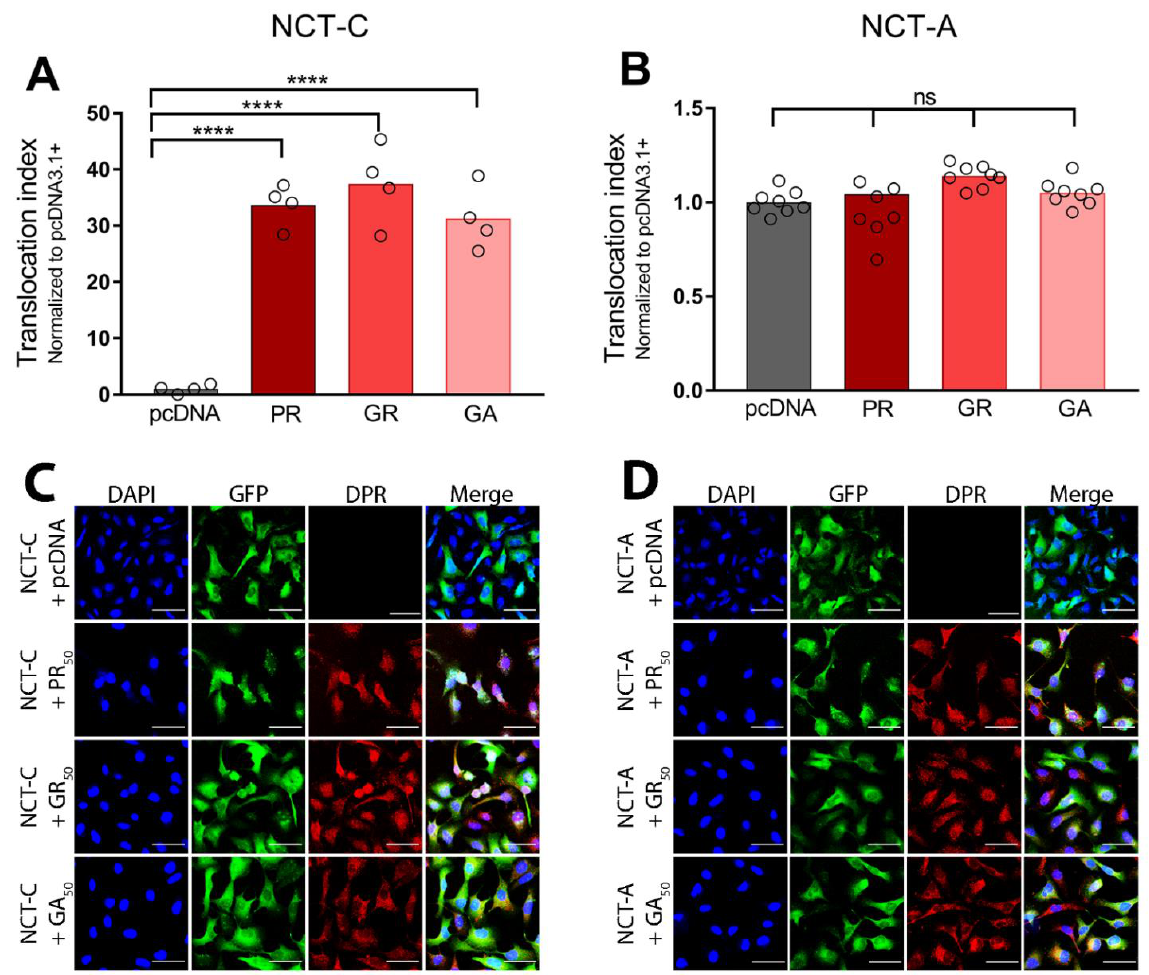
Figure 3. DPRs disrupt the classical nuclear export pathway. ( A ) Bar graph of the translocation index of the NCT-C biosensor after 24 h transfection of an empty vector control (pcDNA3.1+), PR 50 , GR 50 , or GA 50 . Translocation indices were normalized to pcDNA3.1+ (1 = GFP predominantly cytoplasmic). Each condition was performed with 4 technical replicates. ( B ) Bar graph of the translocation index of the NCT-A biosensor after 24 h transfection of an empty vector control (pcDNA3.1+), or PR 50 , GR 50 , or GA 50 . Translocation indices were normalized to pcDNA3.1+ (1 = GFP predominantly cytoplasmic). Each condition was performed with 8 technical replicates. ( C ) Representative images of U-2 OS cells expressing the NCT-C biosensor (green) transfected with empty vector control (pcDNA), or 24 h PR 50 , GR 50 , or GA 50 overexpression conditions. Scale bar = 80 µ m. ( D ) Representative images of U-2 OS cells expressing the NCT-A biosensor (green), transfected with empty vector control (pcDNA), or 24 h PR 50 , GR 50 , or GA 50 overexpression conditions. Scale bar = 80 µ m. Two-way ANOVA; F (3, 40) = 101.8; **** p < 0.0001; ns = non-significant. Statistical results can be found in Table